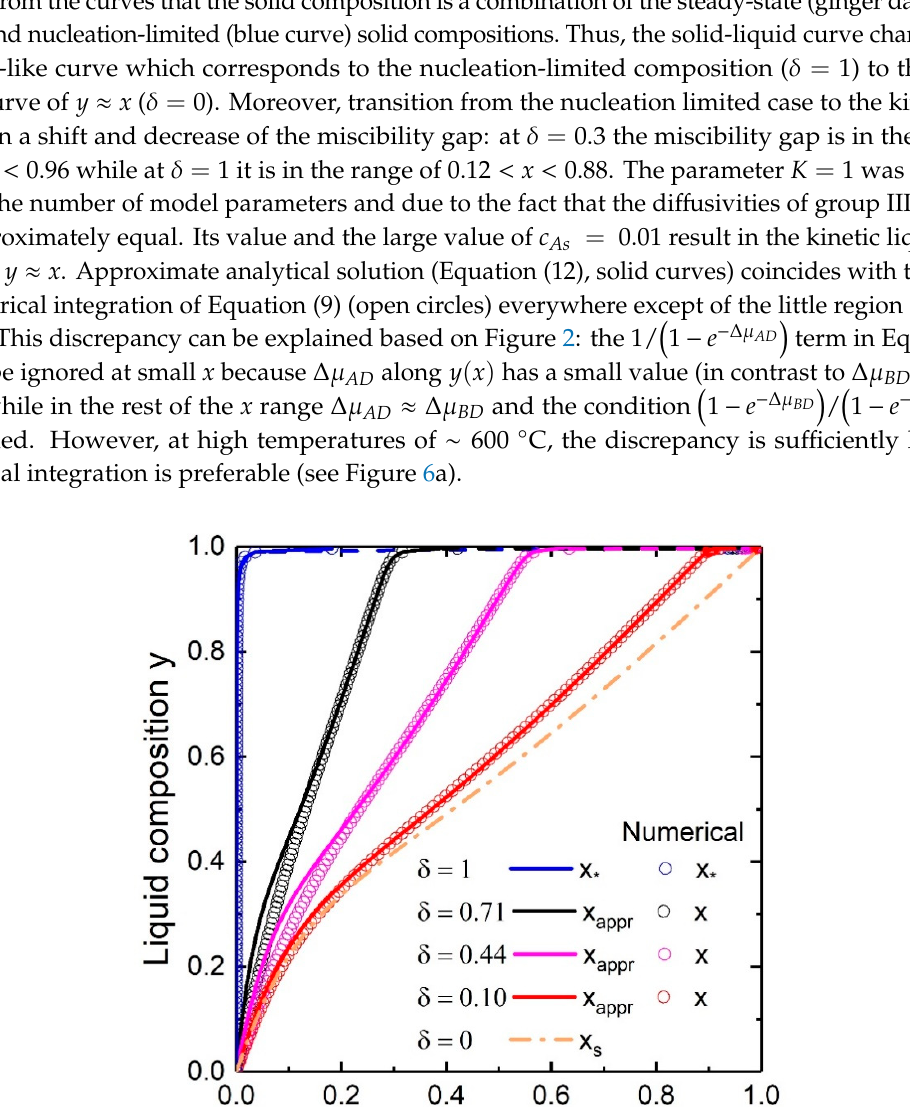
Figure5showstheevolutionoftheliquid-solidcompositiondependenceforAu-catalyzedIn x Ga 1 − x As NWs with the relative nucleus size ( δ = 1, 0.7, 0.3, 0.05, 0) at T = 400